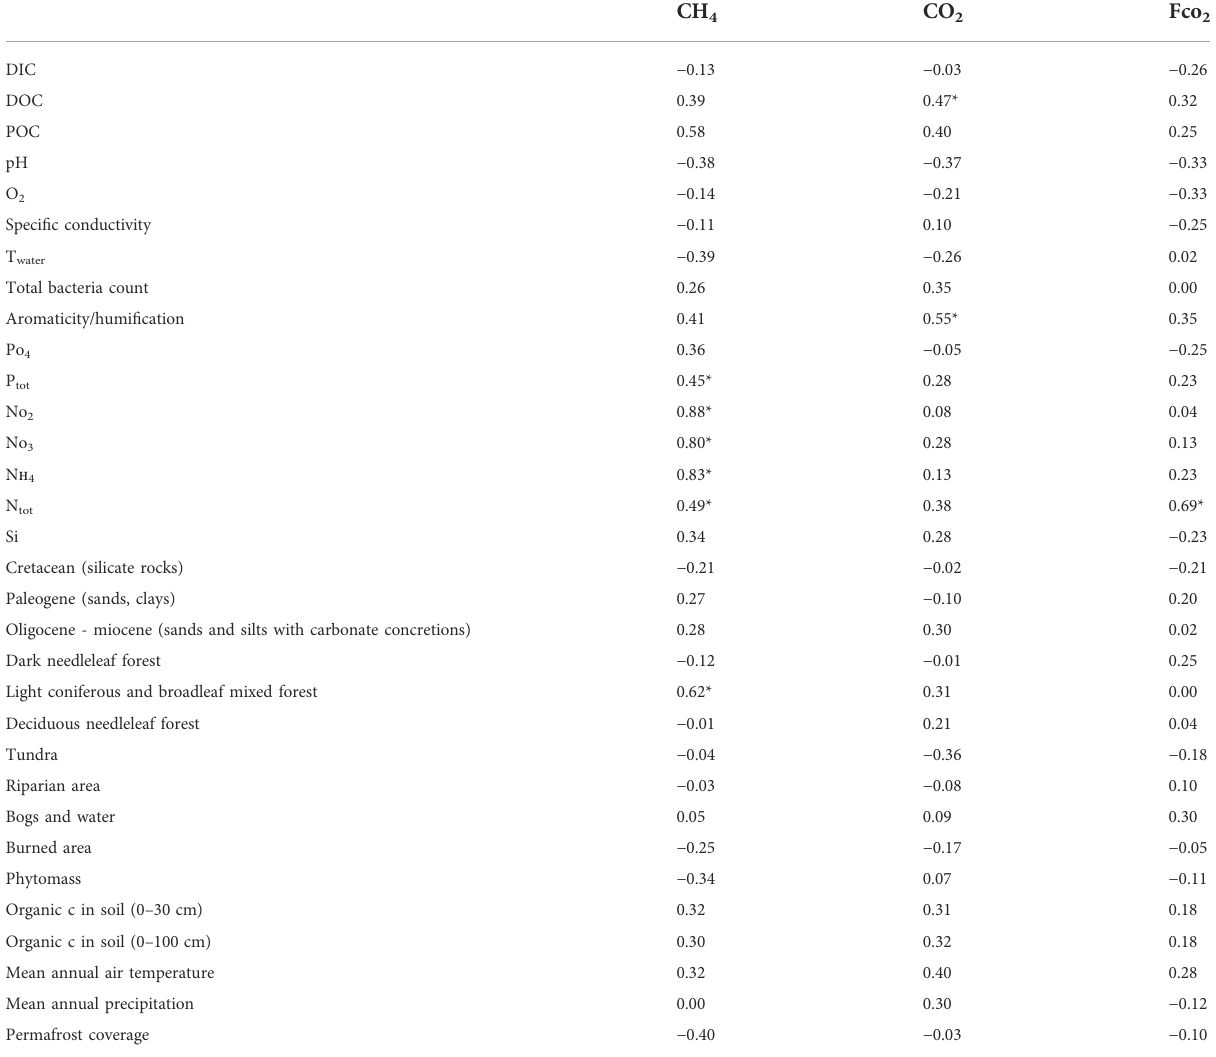
TABLE 2 Pearson correlation matrix of measured FCO 2 , CO 2 , and CH 4 concentrations with hydrochemical parameters of the water column and landscape parameters of the tributaries and the main stem of the Taz